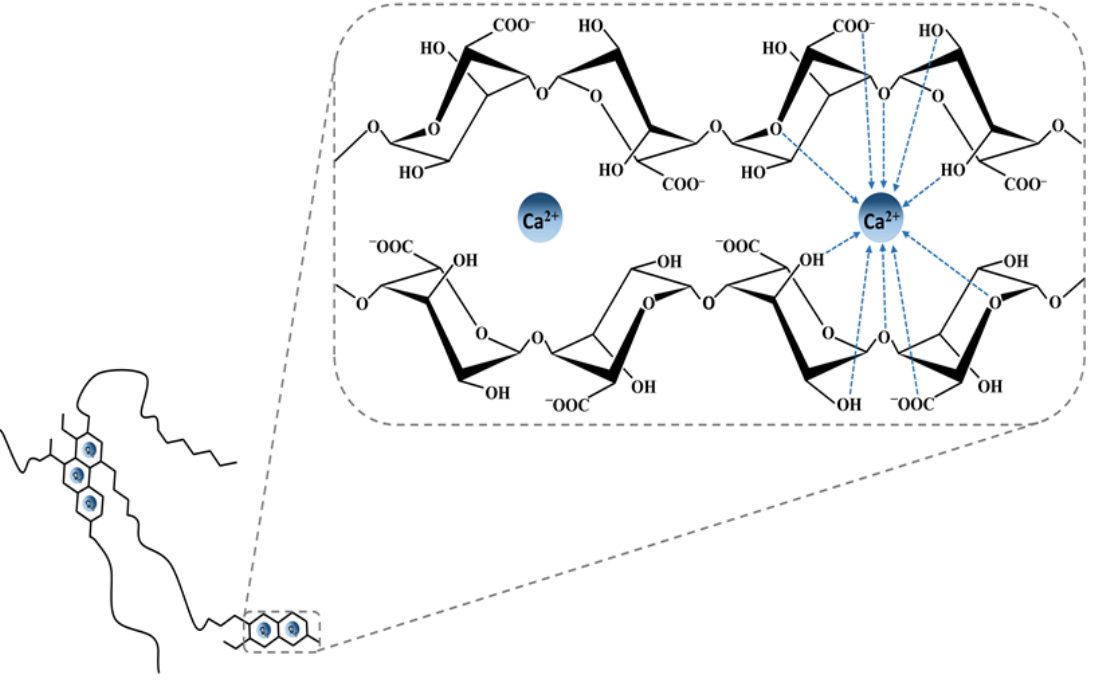
Figure 4. Model describing the interactions between alginate G-blocks and divalent cations (Ca 2+ ), which results in ionic gel formation.